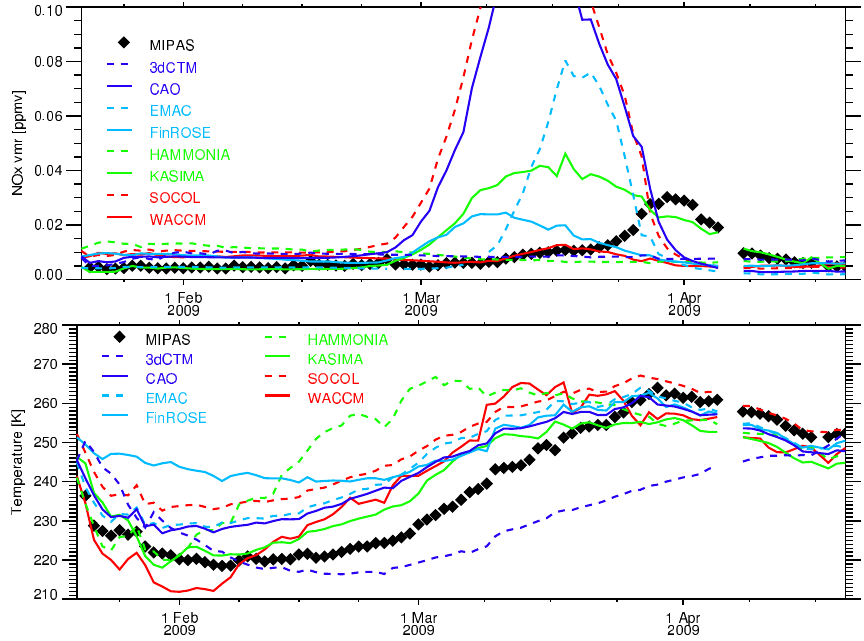
Figure 17. MIPAS-NOM and modelled temporal evolutions of NO x at 0.5hPa (top) and of temperature at 0.2hPa (bottom) within 70–90 ◦ N during the ES